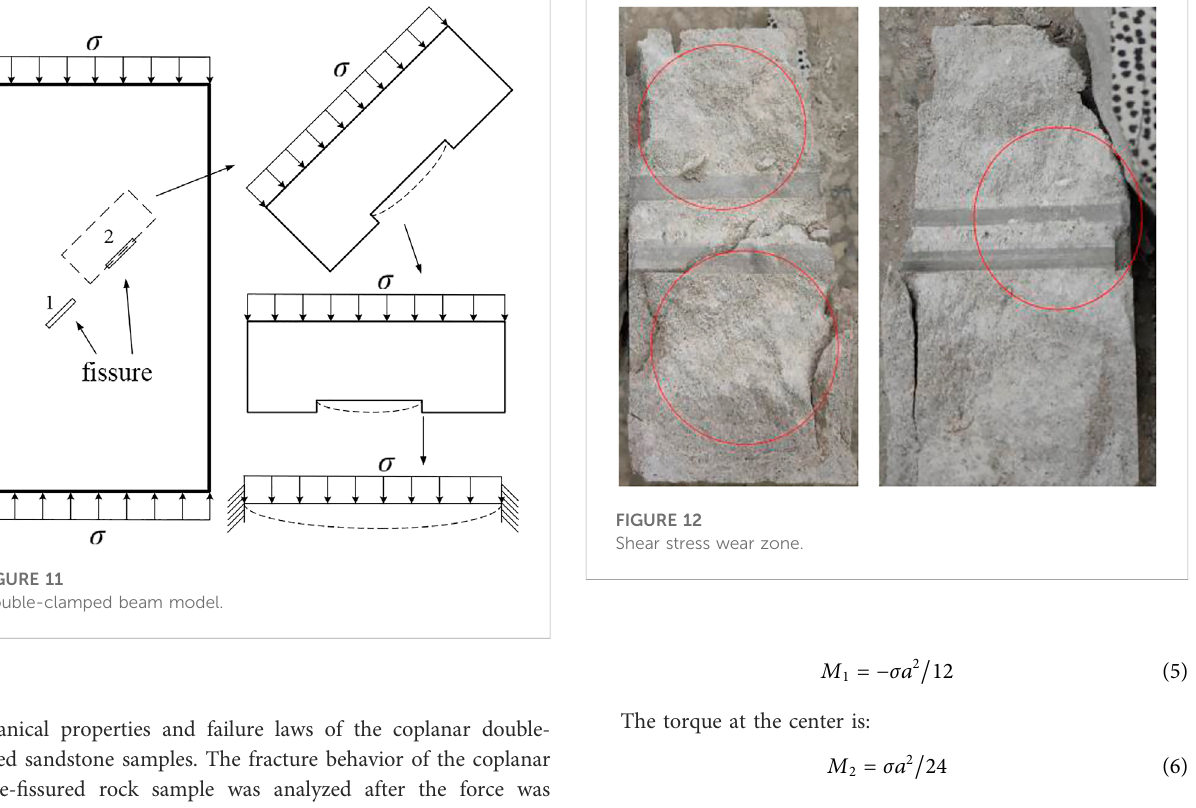
FIGURE 12 Shear stress wear